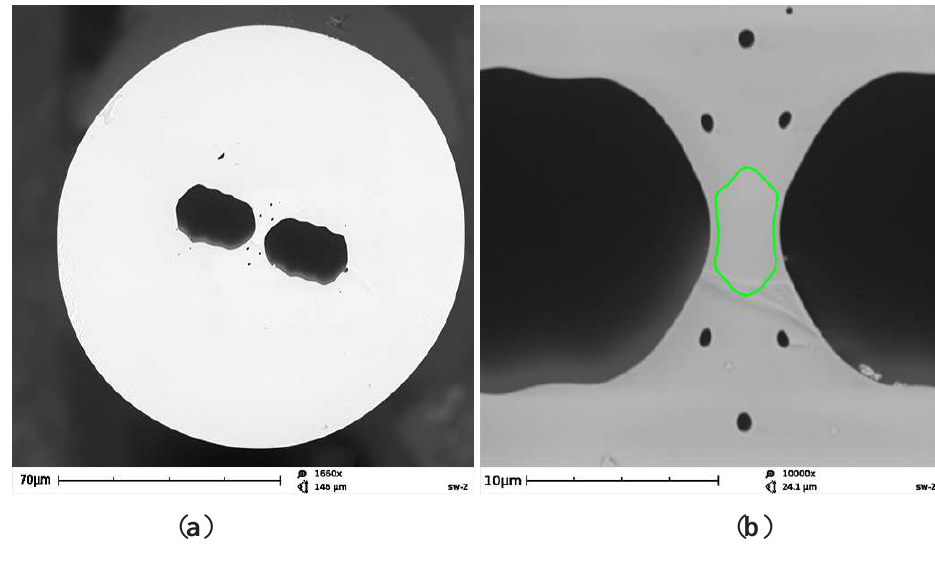
Figure 2. Structure of the fiber under test: general view of the fiber cross-section ( a ), enlarged image of the central region with green line showing core boundary ( b